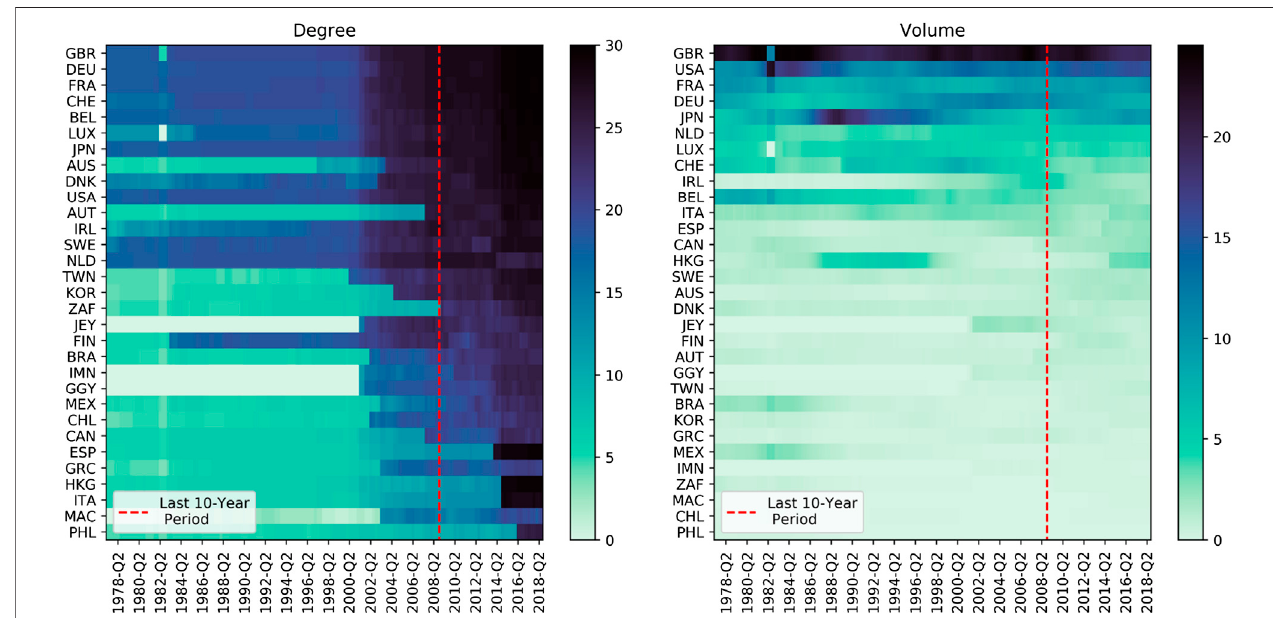
FIGURE2| Temporalevolutionof: (Left) thedegree,and (Right) thevolumeofeachcountryovertime.Thesortingorderofcountriesisbasedontheaverageofthe last 10-year period.